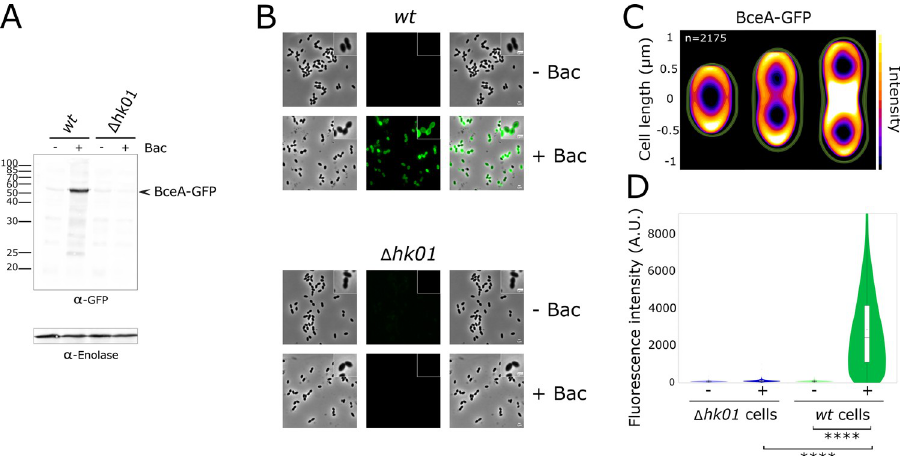
Fig 3. Analysis of BceAB-GFP overexpression in S . pneumoniae upon bacitracin treatment. These experiments were conducted in R800 strains in which the hk01 gene was either intact (wt) or deleted ( Δ hk01 ). In both strains, the gfp gene was fused to the gene encoding the nucleotide-binding domain of BceAB. (A) Western blot analysis of BceAB-GFP expression in wt or Δ hk01 cells previously bacitracin-treated (+ Bac) or untreated (- Bac). Crude bacterial extracts are revealed with anti-GFP and anti-Enolase antibodies, the later providing a protein loading control. The arrow indicates the position of GFP fused to the nucleotide-binding domain of BceAB. (B) Fluorescence microscopy of S . pneumoniae cells analyzing the bacitracin-dependent expression of BceAB-GFP in wt or Δ hk01 strains. Phase contrast (left panel), GFP fluorescent signal (middle panel) and overlays between phase contrast and GFP images (right panel) are shown. Enlargement is shown on upper right corners of each panel. Scale bar, 1 μ m. (C) Heat maps representing the localization patterns of BceAB-GFP during the cell cycle. The n-values represent the number of cells analyzed in a single representative experiment. The images and n values are representative of experiments performed in triplicate. (D) Violin plots showing the distribution of cellular fluorescence intensities in individual cells showed in panel B. The boxes in the violin plots indicate the 25 th to the 75 th percentile and the whiskers indicate the minimum and maximum value. The mean and the median are indicated with a dot and a line in the box, respectively. The P value ( ���� , p < 0.0001) was derived from a Mann-Whitney test. A total of 10, 442 cells were analyzed.